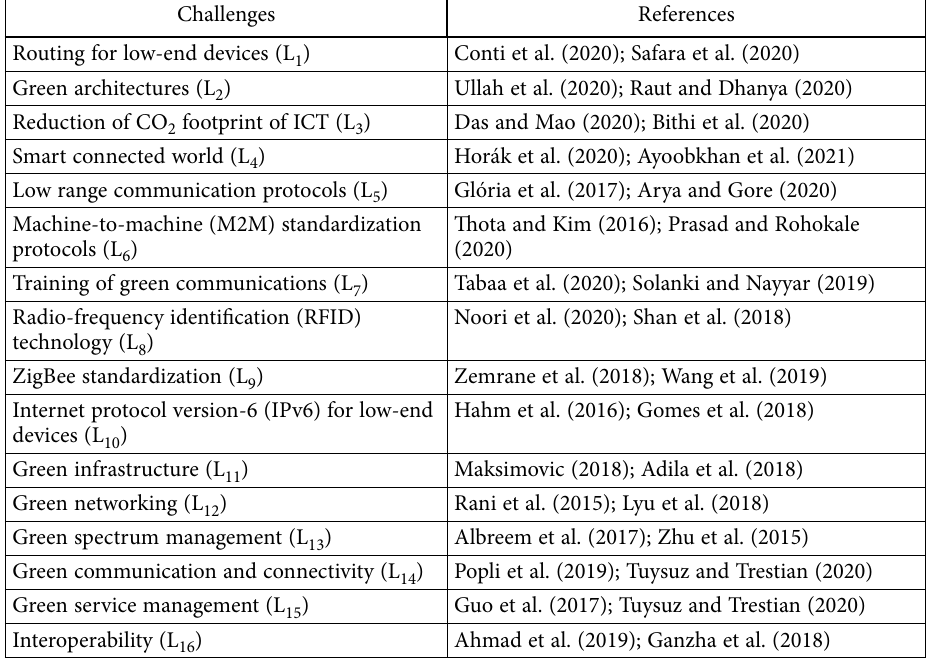
Table 1. G-IoT technologies challenges towards the achievements of sustainable development